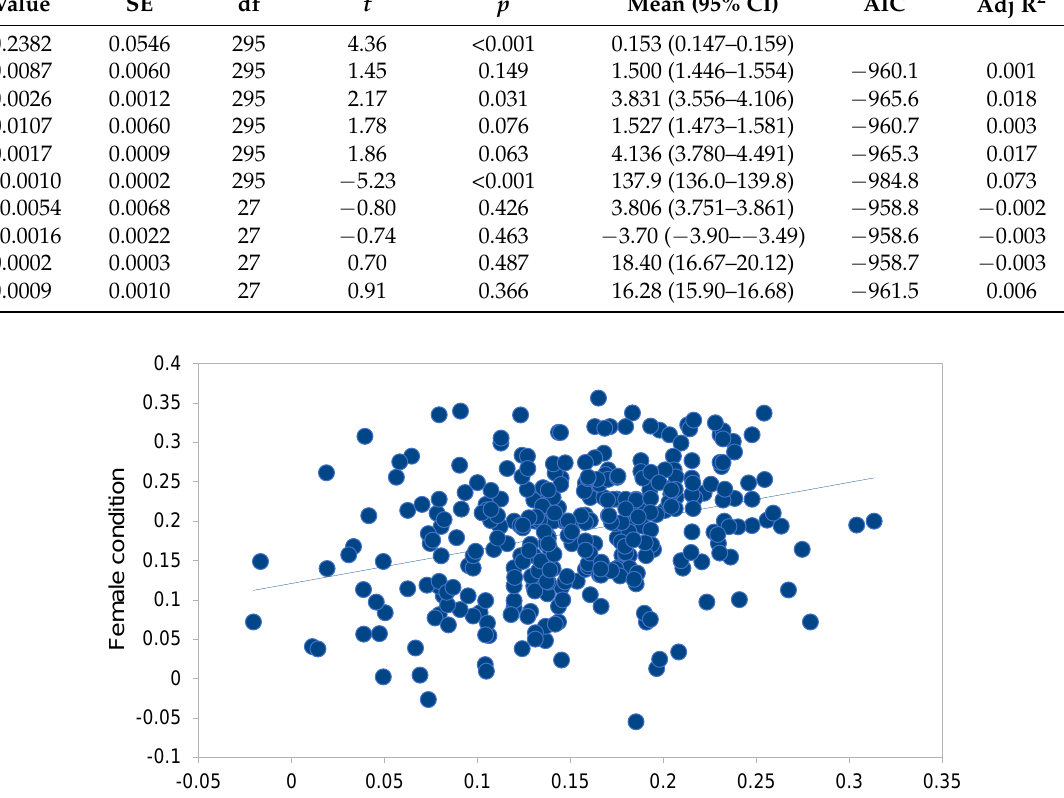
Figure 2. Relationship between the male body condition and female body condition of breeding pairs of Tawny Owls Strix aluco in the studied population in southern Finland (f(x) = 0.428x + 0.121, r = 0.316, df = 330, p < 0.001).